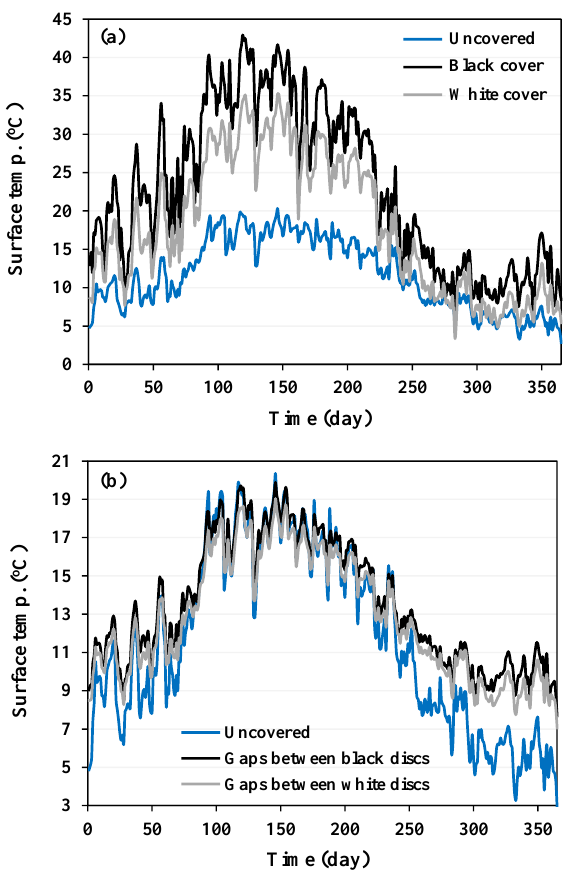
Figure 9. (a) The evolution of temperature on the top surface of floating discs and on the surface of uncovered reservoir; (b) com- parison of surface water temperature of the uncovered reservoir and of water gaps between floating elements. The plots show simulation results for a hypothetical reservoir in Majadas